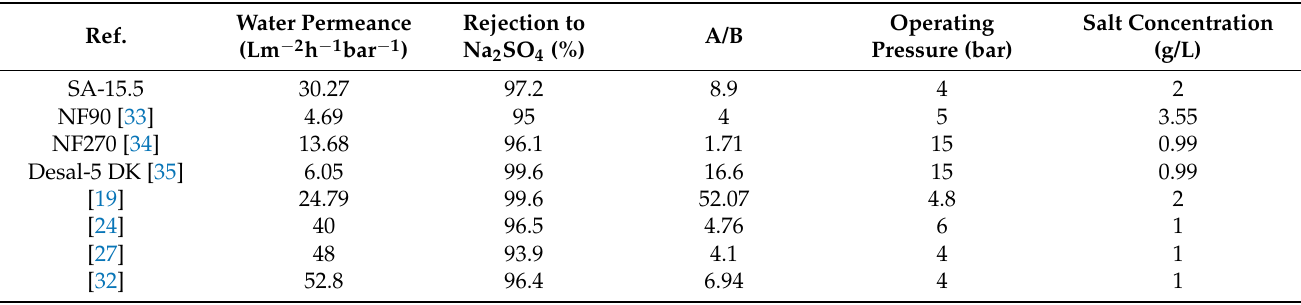
Table 2. The summary of detailed nanofiltration performance of SA-15.5 and other high-performance nanofiltration membranes in Figure 6d.